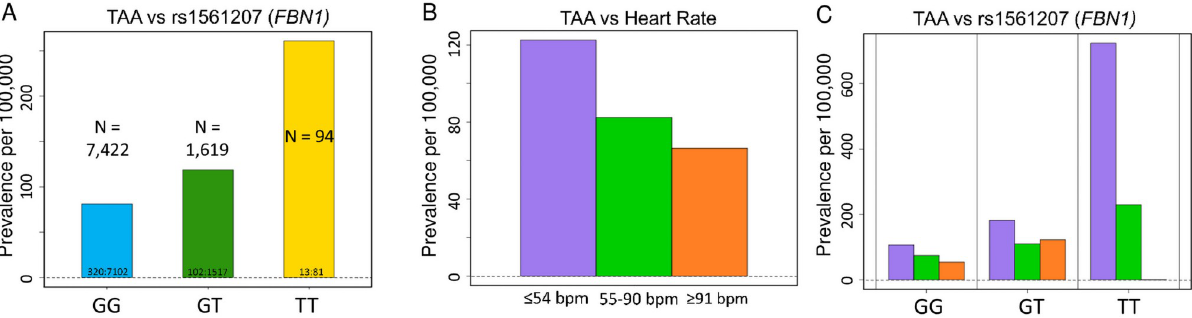
Fig 3. Prevalence of TAA increases with FBN1 variant rs1561207 status and bradycardia. (A) Increase in TAA prevalence per 100,000 participants in the UK Biobank is noted in the homozygotes for the minor allele (T/T) in comparison to the heterozygotes (C/T) and the noncarriers (C/C) in a pronounced stepwise, “dosage-dependent” manner (P-value = 1.57x10 -6 , OR per T allele 1.615). Bars labeled with ratio of cases: Controls. (B) Prevalence of TAA rises with bradycardia (purple, heart rate � 54 beats per minute, bpm) in a stepwise manner from tachycardia (orange, defined as heart rate � 91 bpm, OR = 1.89) to normal rate (green, heart rate 55 to 90 bpm, OR = 1.62) to bradycardia (purple, heart rate � 54 bpm, OR = 2.09). P- value = 0.01622 by Pearson’s Chi-squared test. ( C ) This relationship is seen in both FBN1 variant carriers (GT) and noncarriers (GG), but the impact of bradycardia is more dramatic in homozygous variant carriers